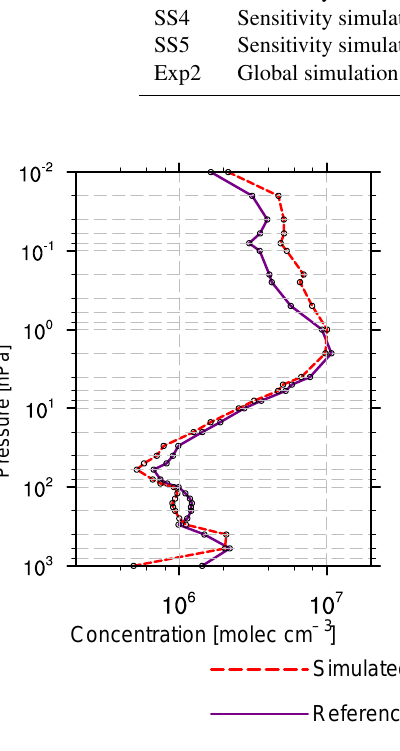
Figure 5. Reference OH concentration in the tropics from ESCiMo experiment RC1SD-base-07 (purple) and OH concentration as sim- ulated in respective boxes